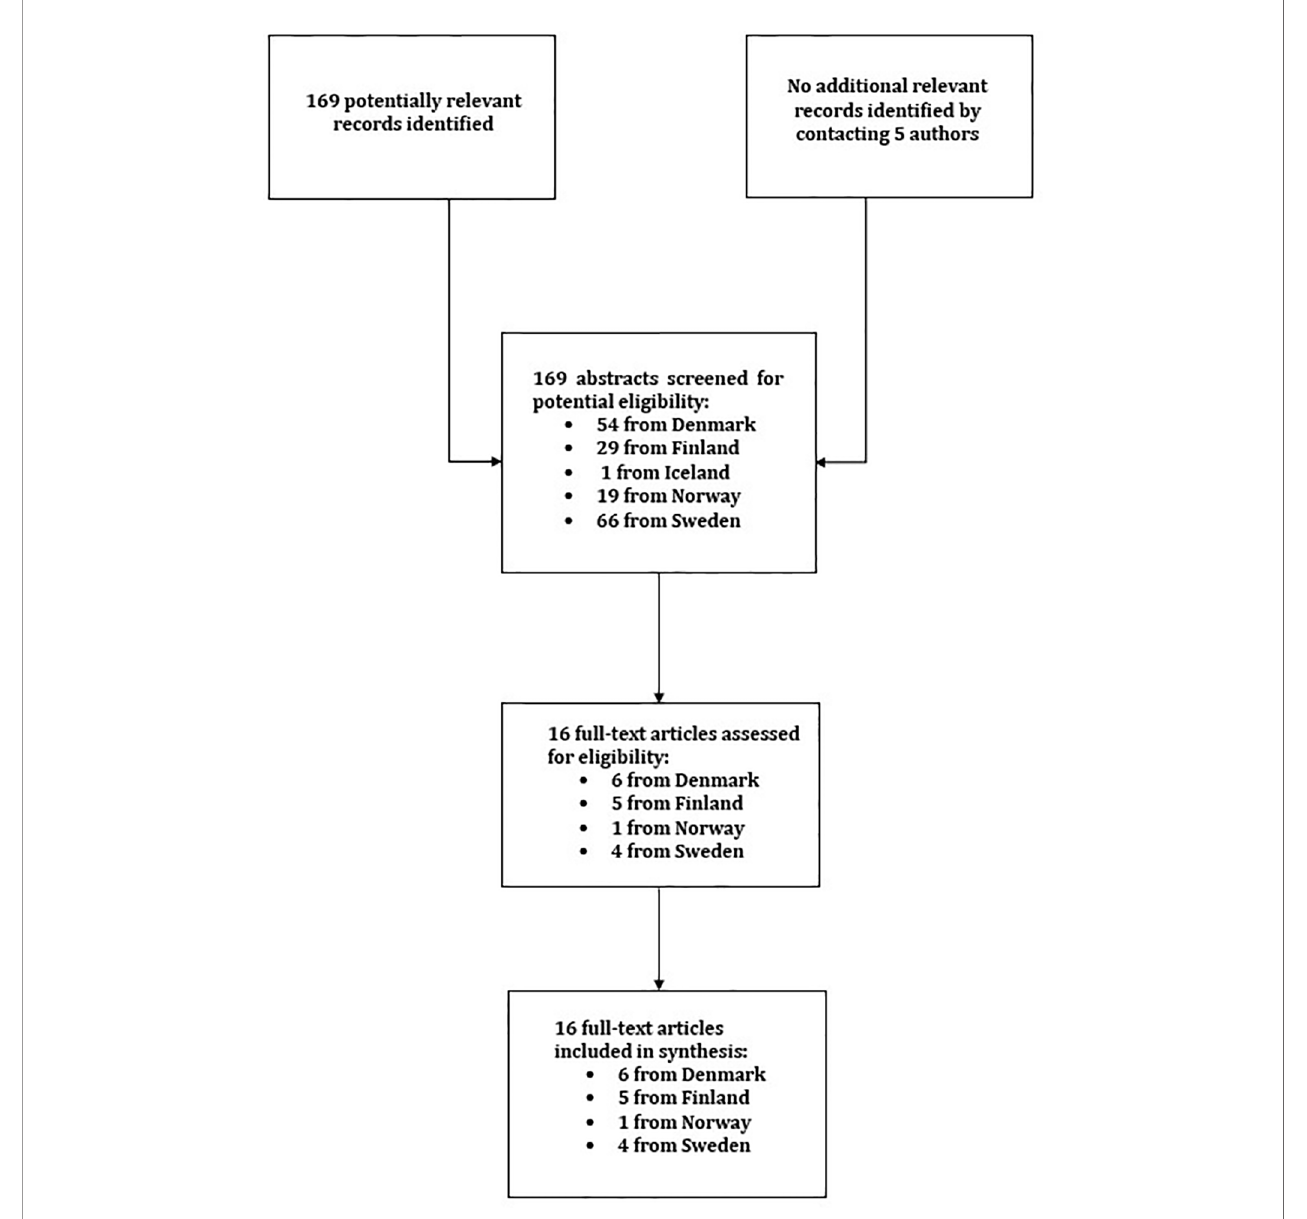
FIGURE 1 | Flow chart of systematic literature